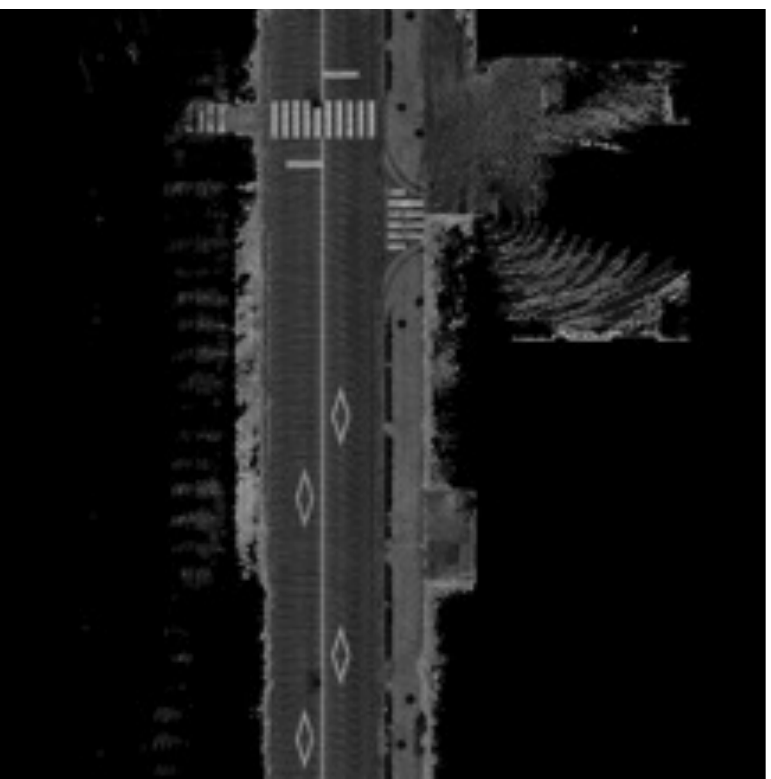
Figure 6. LiDAR map. The resolution of the image is 0.125 [m]. Each pixel represents an infrared reflectivity. Road surface patterns such as white lines are mapped in white because of their high re-